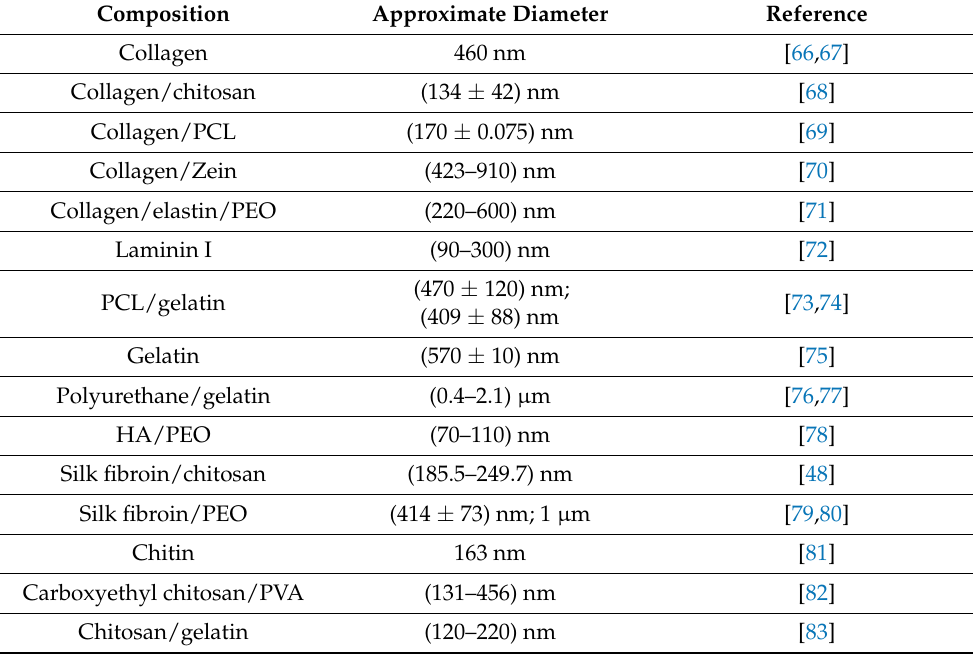
Table 2. Electrospun nanofibers mimicking the ECM of the